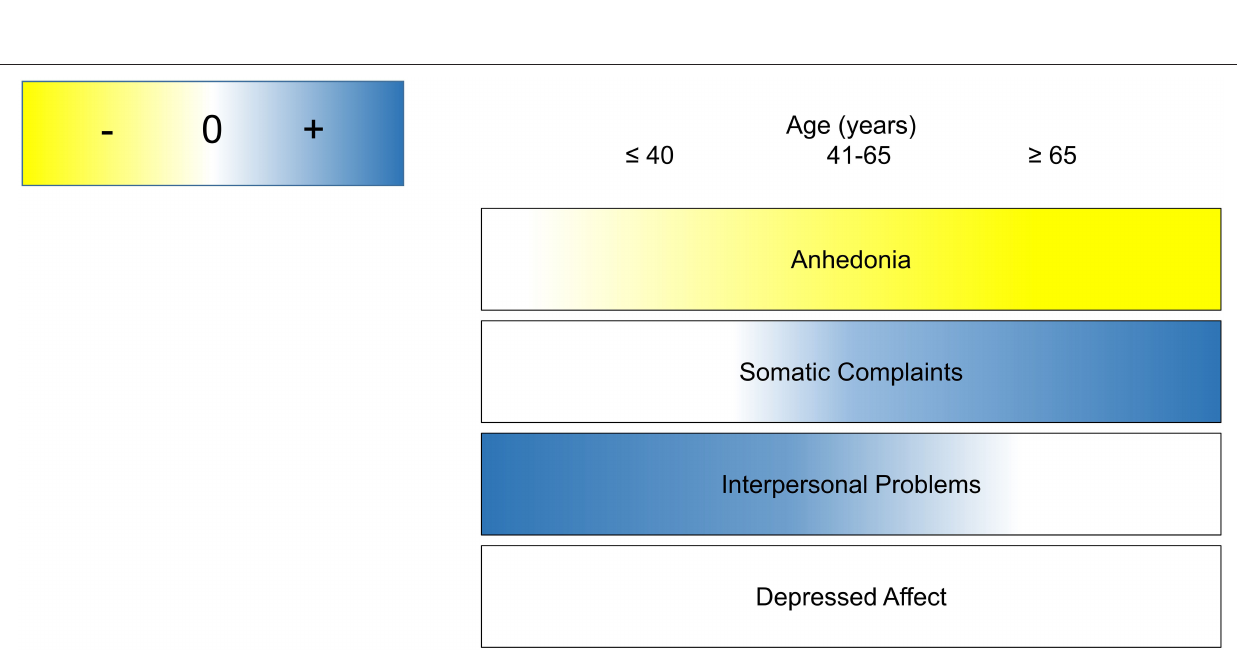
Frontiers in Psychiatry |